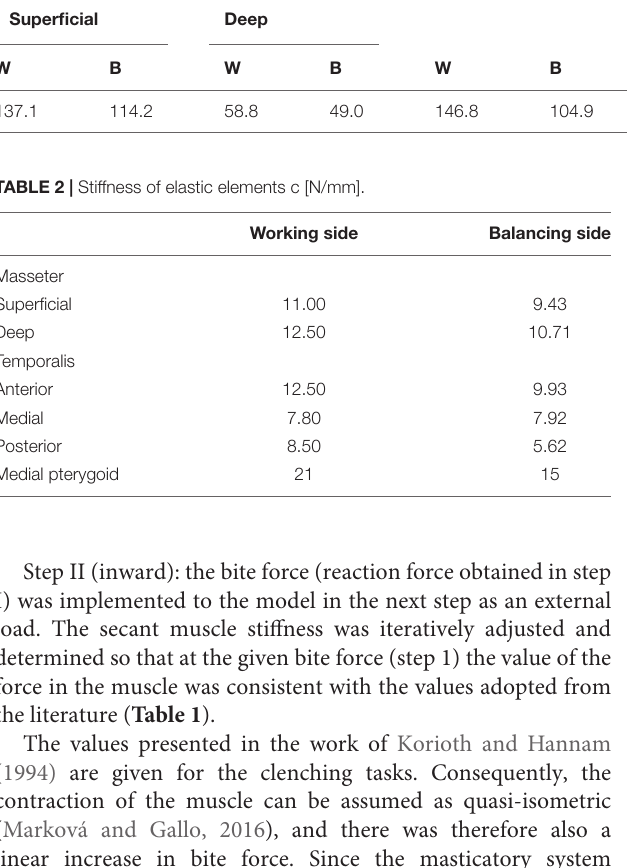
TABLE 1 | Muscle force values [N]: W, working side; B, balancing side. Masseter